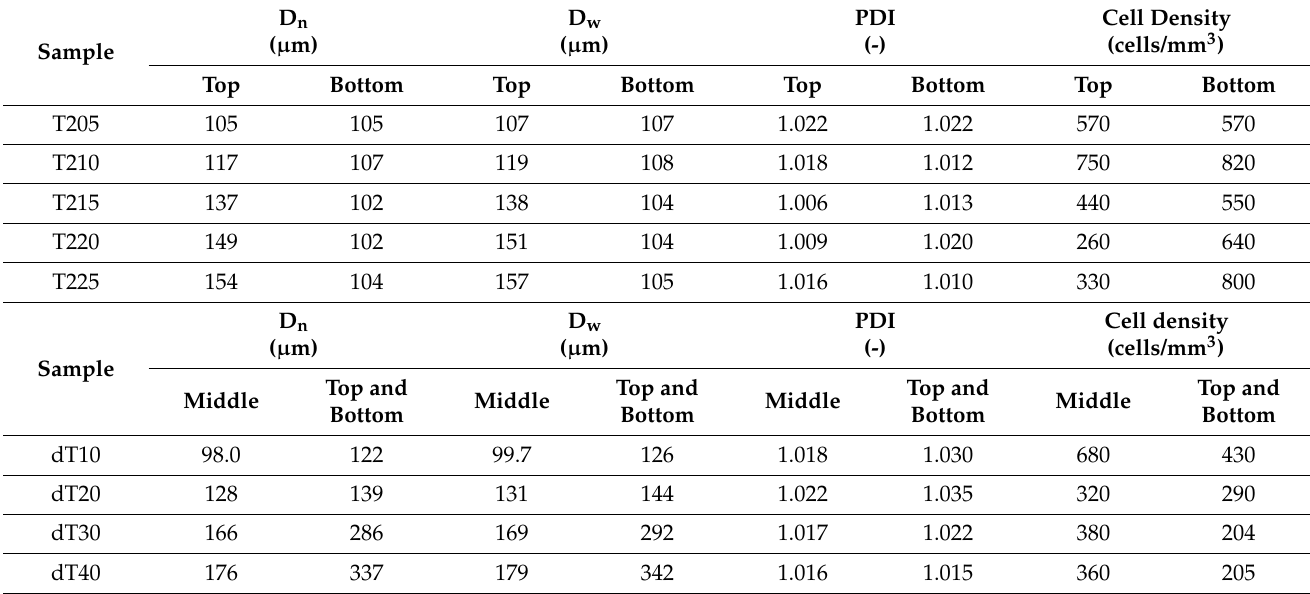
Table 2. Morphological characteristics of the uniform and graded POE